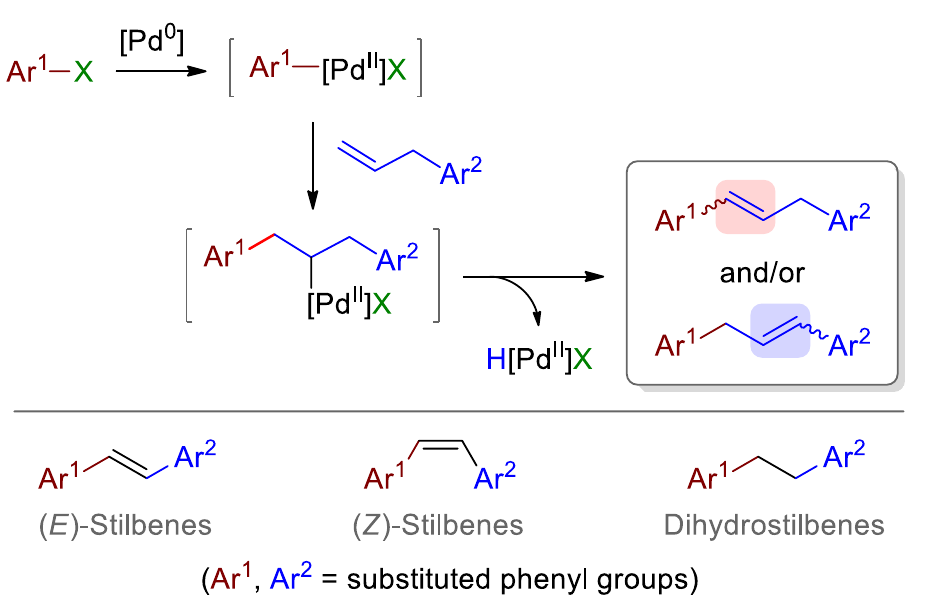
Scheme 1. Synthesis of 1,3-diarylpropene derivatives by the Heck reaction. Comparison of the structures of the products with those of stilbenes and